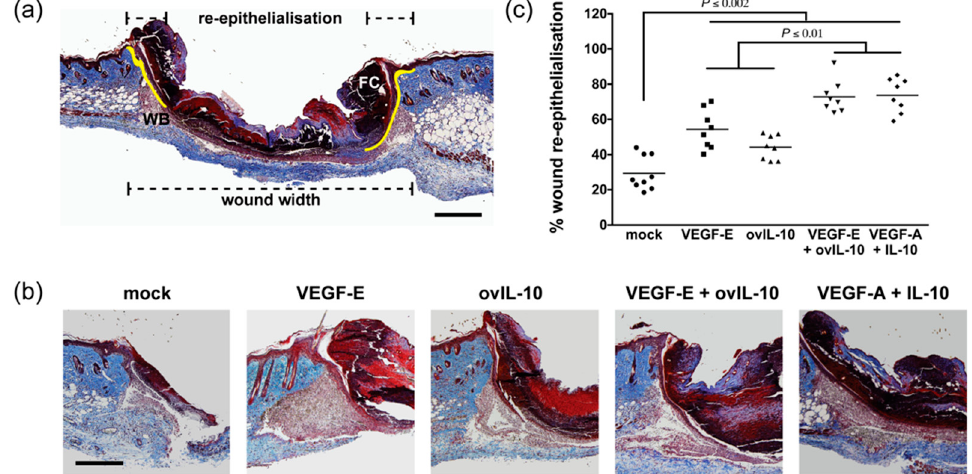
Figure 2. VEGF-E and ovIL-10 synergistically enhance wound re-epithelialisation. ( a ) Representative image of a day 3 wound section, stained with MSB trichrome. The neo-epidermis–dermis boundary is highlighted in yellow. Dashed lines indicate wound width, distance between cut edges of the panniculus carnosus, and coverage by the neo-epidermis. WB = wound bed; FC = fibrin clot. Scale bar = 300 µ m. ( b ) Representative images of day 3 wound sections, showing the extent of re-epithelialisation 24 h after SC injection of the indicated treatment. Scale bar = 150 µ m. ( c ) Percentage wound re-epithelialisation at day 3 post-wounding. Data are presented with each symbol representing an individual wound, and the line indicating the mean of 8 wounds, p values are indicated.